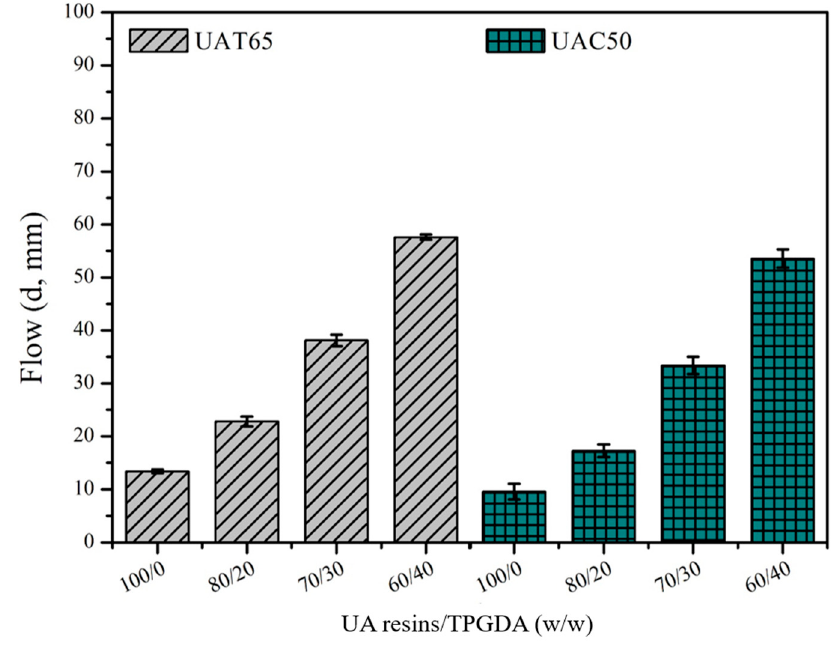
Figure 7. Flow analysis of UA resins with various weight ratios of UAT65 / tripropylene glycol diacrylate (TPGDA) or UAC50/TPGDA according to ISO 4049:2009.